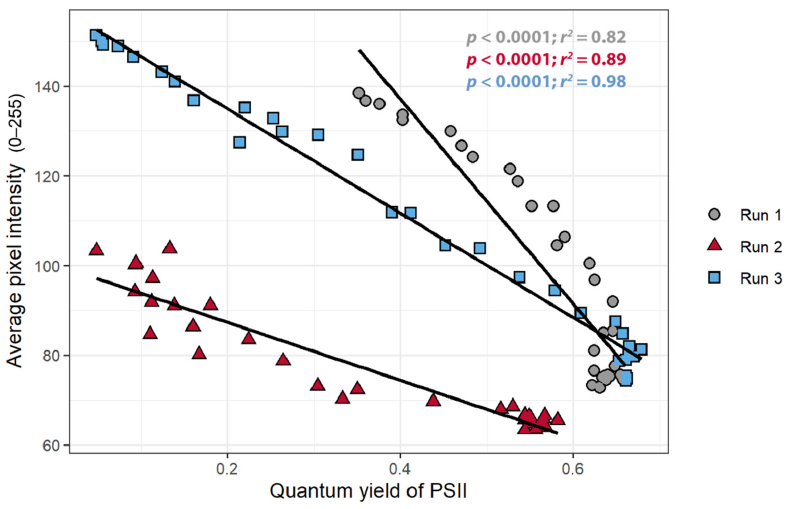
Figure 5. The relationship between the quantum yield of photosystem II and the average pixel intensity in chlorophyll fluorescence images of Catharanthus roseus treated with atrazine. To confirm that a change in pixel intensity was associated with a change in chloro- phyll fluorescence, the relationship between the pixel intensity and nARFS was examined.